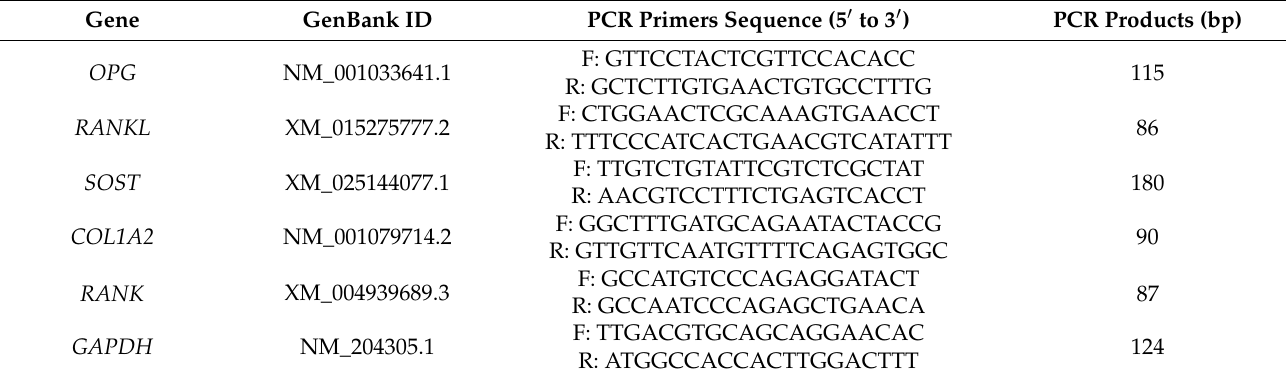
Table 2. Real-time PCR primers and amplified PCR product